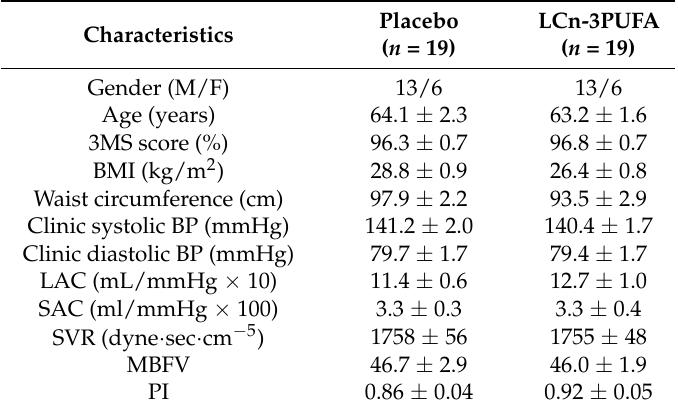
Figure 1. Consort diagram of participants who were screened, enrolled and completed the study. Table 1. Participant’s disposition at